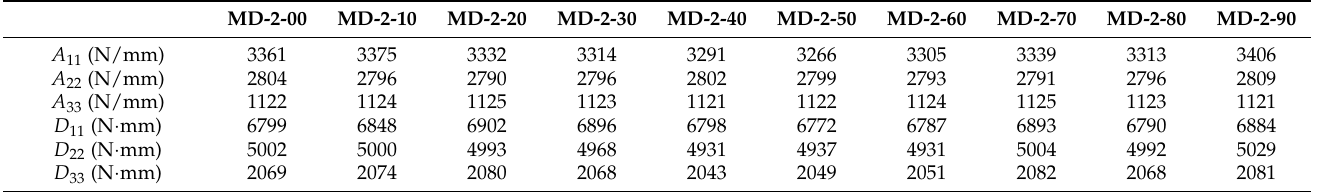
Table 6. The selected stiffnesses with 2% imperfections of compression in the MD shape and with different offsets.